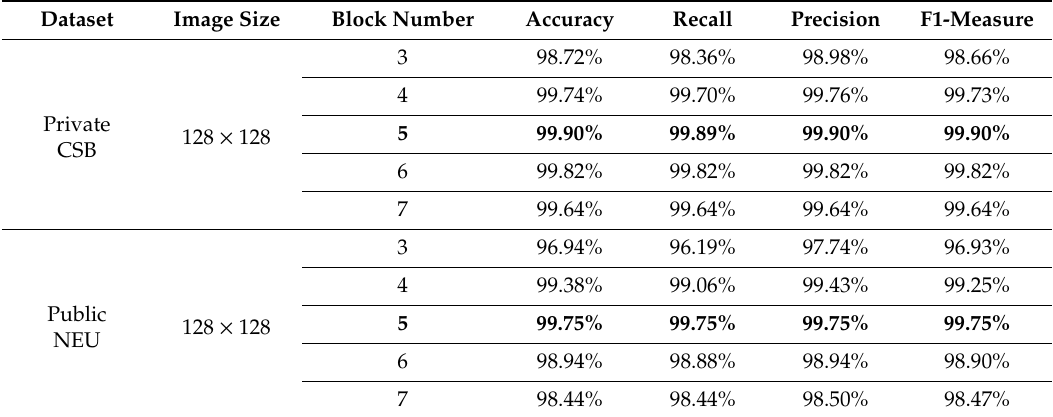
Table 8. Recognition performance of the proposed network using di ff erent numbers of SurfNetv2 blocks.